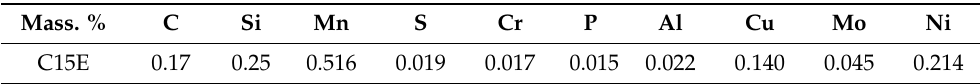
Table 1. Chemical composition of C15E low carbon steel. Mass.